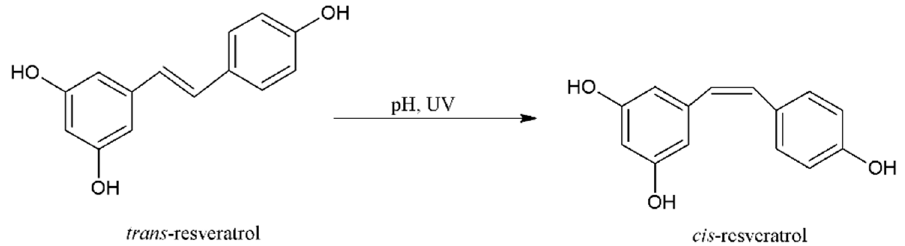
Figure 2. Isomerisation of